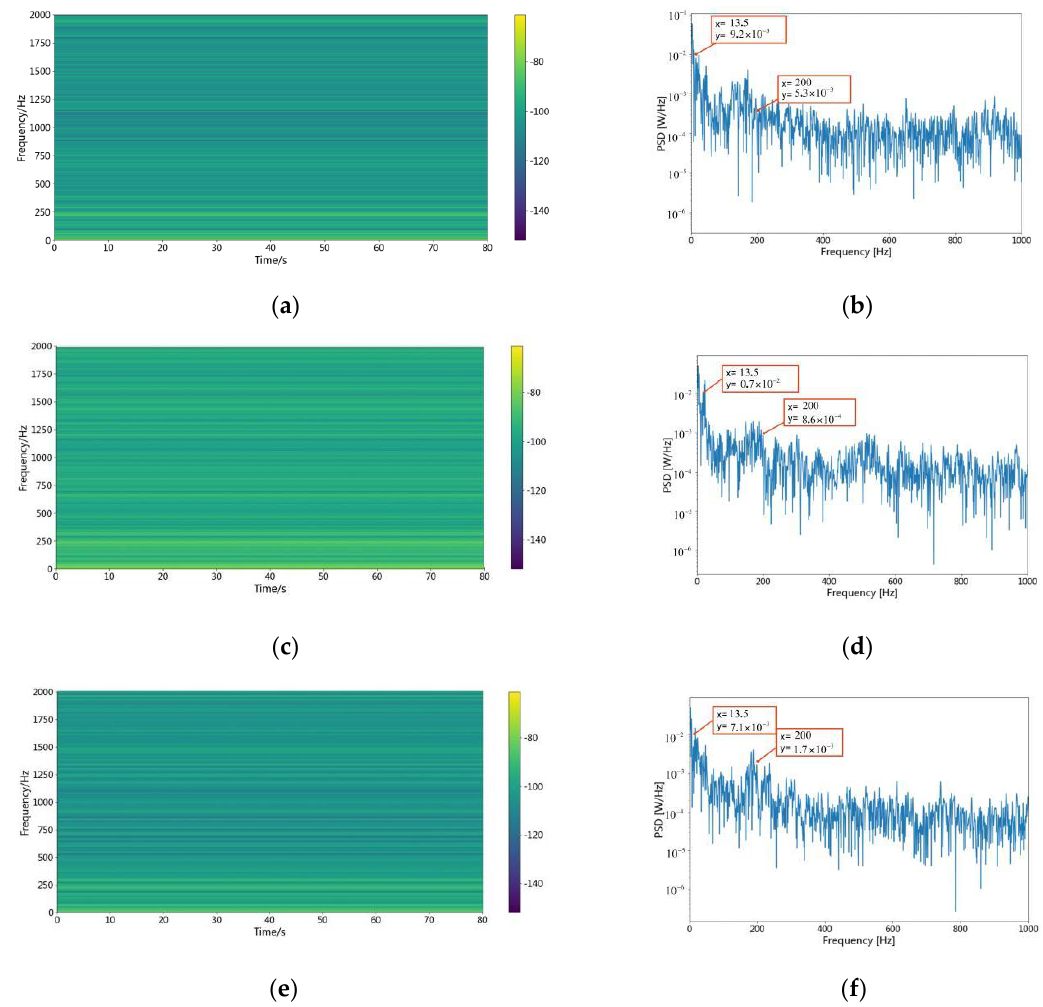
Figure 7. The spectrogram and power spectrum density of Class IV with camResNet. ( a , c , e ) The spectrogram of extracted features for Class IV vessel by camResNet; ( b , d , f ) The power spectrum density of extracted features for Class IV vessel by camResNet.